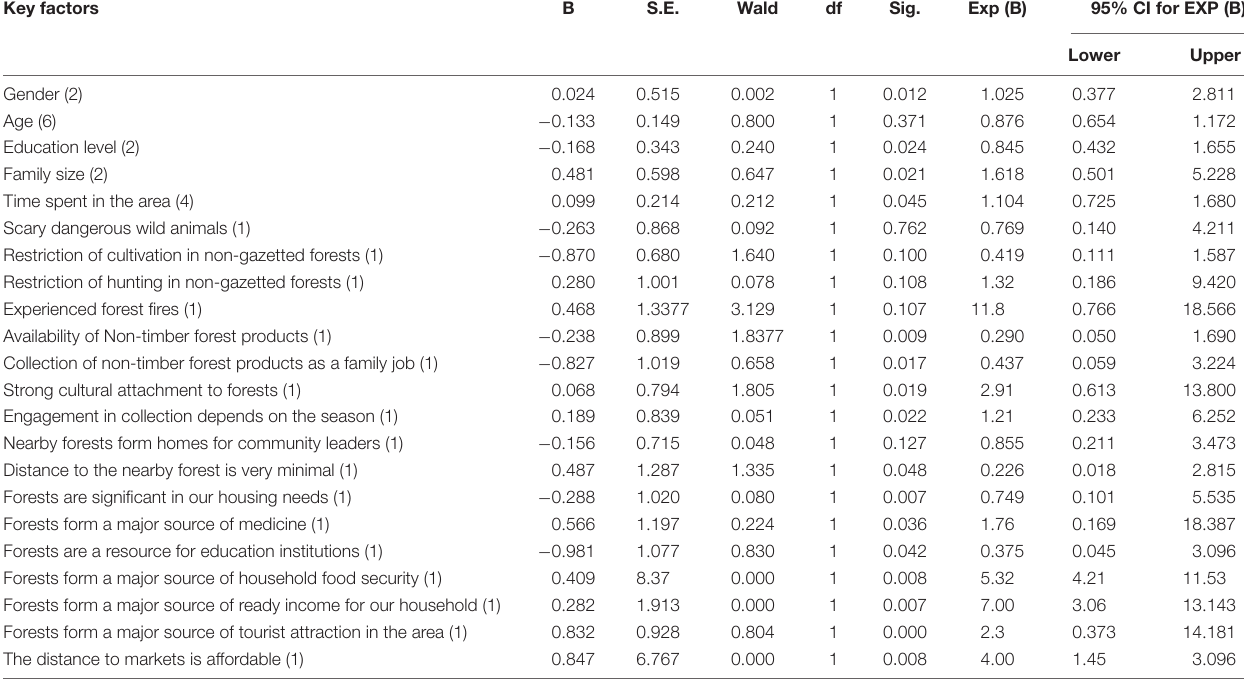
TABLE 4 | Multivariate analysis of key factors characterizing the dependence on non-timber forest